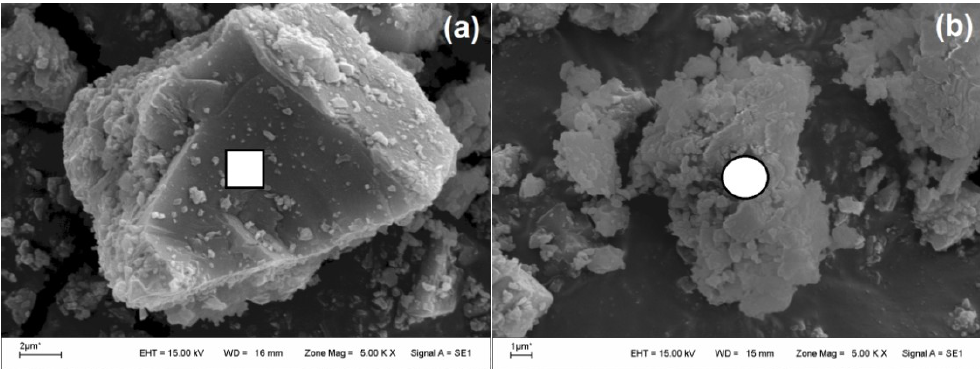
Figure 2. SEM micrographs corresponding to Mi sample: ( a ) microcline particle, ( b ) calcite particle. Table 2. Electron probe microanalysis (% atomic) corresponding to particles present in Mi sample. Particle Al Si